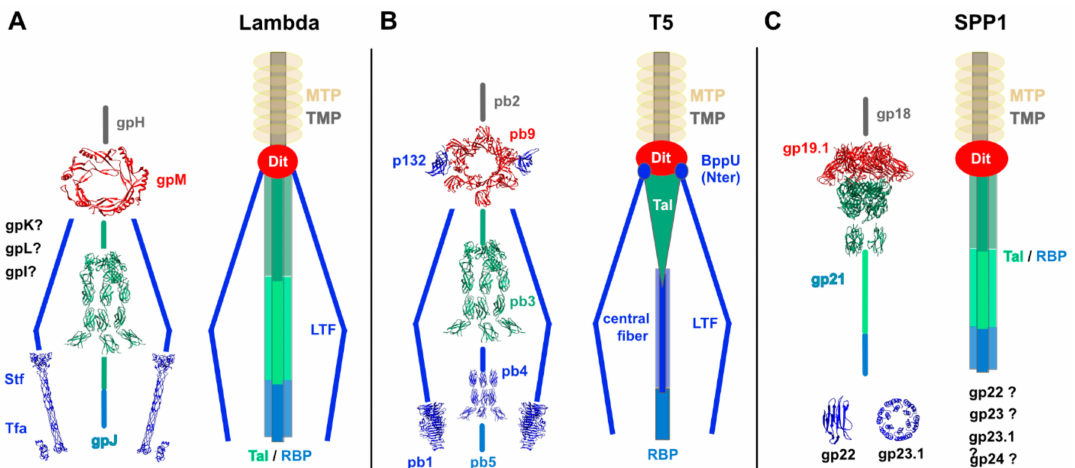
Figure 4. Architecture of the phage lambda, T5, and SPP1 host adhesion devices targeting membrane proteins. ( A ) Right. The lambda host adhesion device is formed by the Dit hexameric ring (gpM) and the long trimeric Tal / RBP (gpJ) central fiber. The positions of gpK, gpL, and gpI proteins in the lambda tail spike are not known. Ur-lambda also contains long tail fibers (LTFs) (Stf and Tfa). Left. Structural models, based on HHpred analyses, of gpM, gpJ middle domains (residues 326-449 and 570-811), Stf C-terminal domains (residues 578-774), and Tfa (residues 62-192). The Dit ring is a tilted view. The crystal structures used to produce these representations are PDB ID 4JMQ [31] for gpM, PDB IDs 3D37, and 5UTK for gpJ, PDB ID 2XGF for Stf [70], and PDB ID 5YVQ for Tfa [72]. ( B ) Right. The T5 host adhesion device is formed by the Dit hexameric ring (pb9), the trimeric Tal (pb3), and central fiber (pb4), and the RBP (pb5). LTFs (pb1) are anchored to the Dit ring via p132. Left. Ribbon representations of the pb9 (PDB ID 4JMQ) and pb1 (PDB ID 4UW8) [73] crystal structures. The Dit ring is a tilted view. Structural models, based on HHpred analyses, of pb3 (residues 528-709 and 735-849), pb4 (residues 6-319), and p132. The crystal structures used to produce these representations are PDB IDs 3D37 and 5UTK for pb3, PDB ID 5UTK for pb4, and PDB ID 3UH8 [30] for p132. ( C ) Right. The SPP1 host adhesion device is formed by the Dit hexameric ring (gp19.1) and the long trimeric Tal / RBP (gp21). The positions of gp22, gp23, gp23.1, and gp24 proteins in the SPP1 tail spike are not known. Left. Ribbon representations of the gp19.1 (PDB ID 2X8K), gp22 (PDB ID 2XC8), and gp23.1 (PDB ID 2XF7) crystal structures [74,75]. Structural models, based on HHpred analyses, of the gp21 N-terminal domains (residues 3-404 and 422-518). The crystal structure used to produce these representations are PDB IDs 3GS9 and 5E53